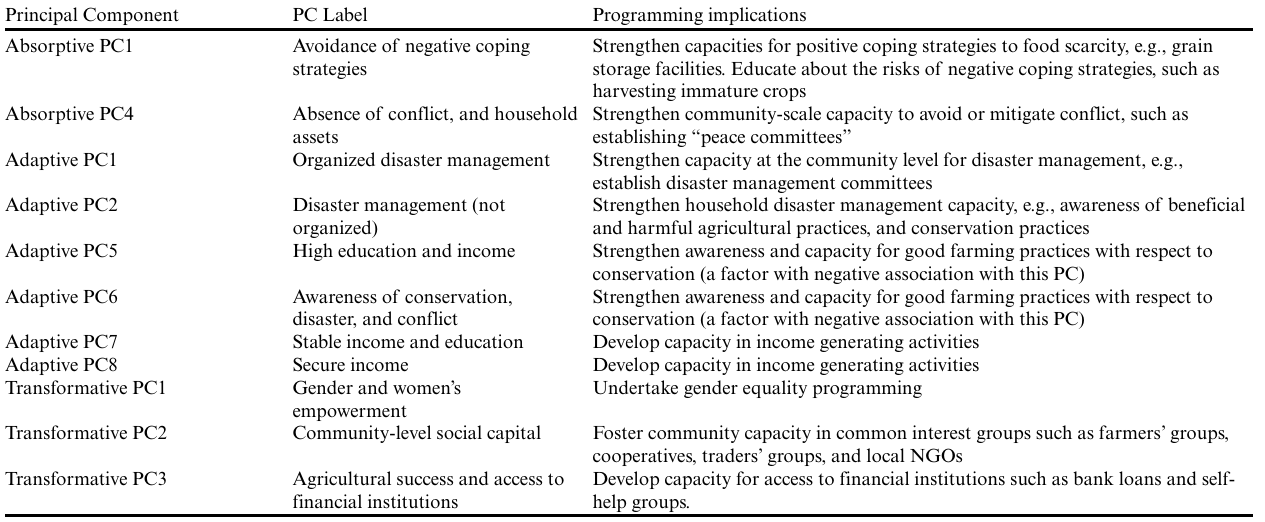
Table 8 . Principal components analysis (PCA) results that inform programming and intervention (South Sudan 2015 Dataset). Principal